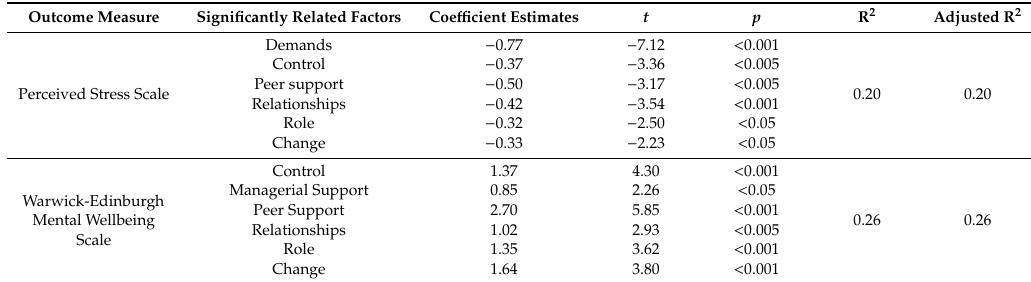
Table 3. Linear regression analyses of the impact of working conditions on the Perceived Stress Scale and Warwick–Edinburgh Mental Wellbeing Scale across all